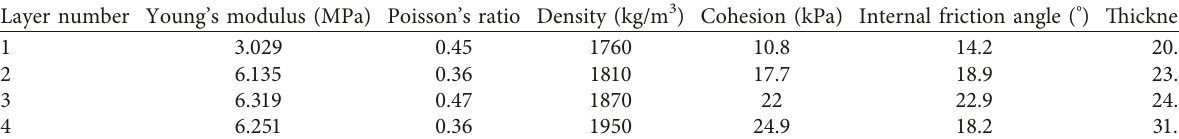
Figure 1: Finite-element mesh model adopted in the 3D FE analyses for soil with long tunnels. Table 1: Properties of different soil layers.